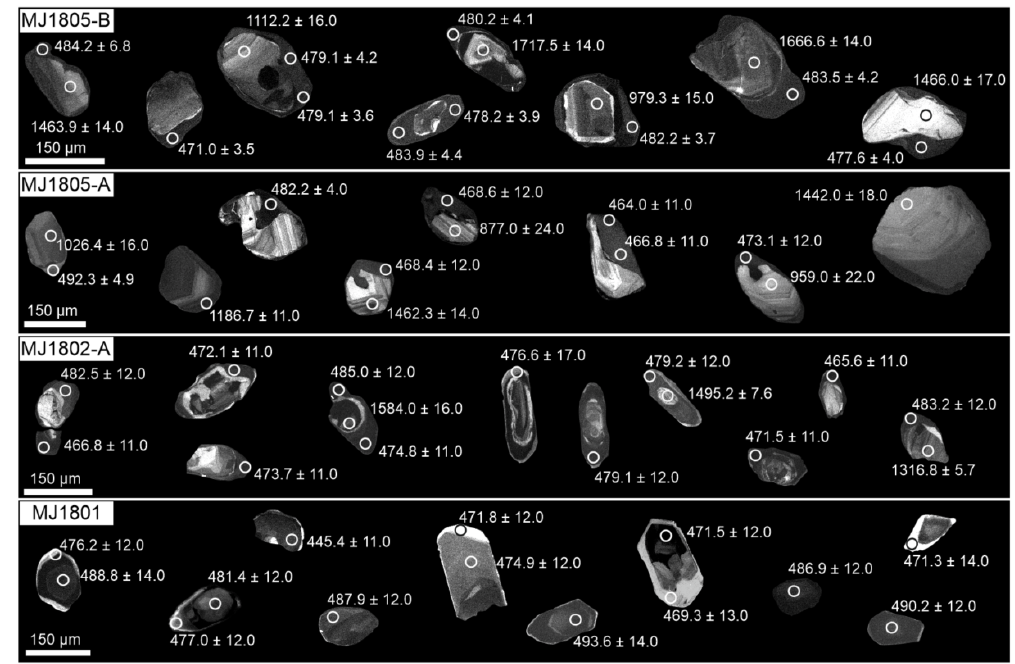
Figure 6. Cathodoluminescence (CL) images of representative zircon grains displaying a variety of microtextures. The white circles mark the analytical spots with obtained 206 Pb/ 238 U ages (for Caledonian ages) and 207 Pb/ 206 Pb for ages >900 Ma.